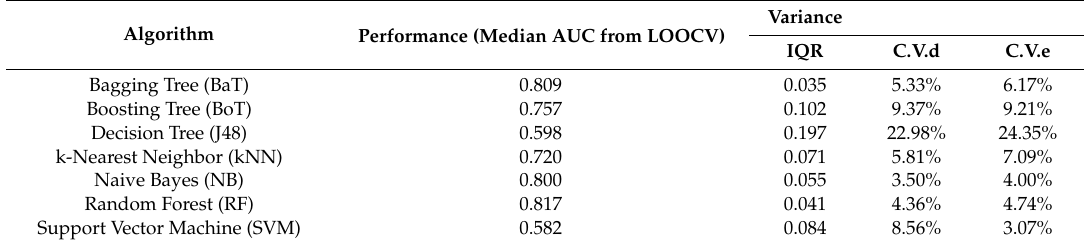
Table 2. Performance of time-invariant biomarkers using di ff erent machine learning algorithms. Algorithm